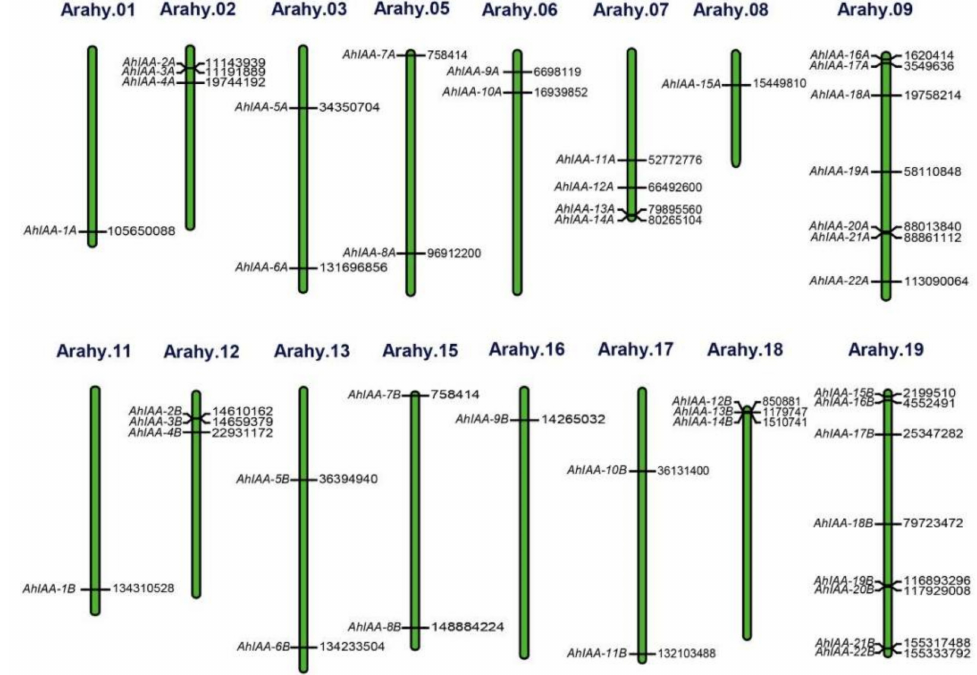
Figure 1. Chromosomal location of 44 AhIAA genes. “Arahy.*” represented chromosome number in cultivated peanut (https://peanutbase.org/gbrowse_peanut1.0, accessed on 10 January 2022). The name and corresponding start position of AhIAA genes were listed on the right and left side,